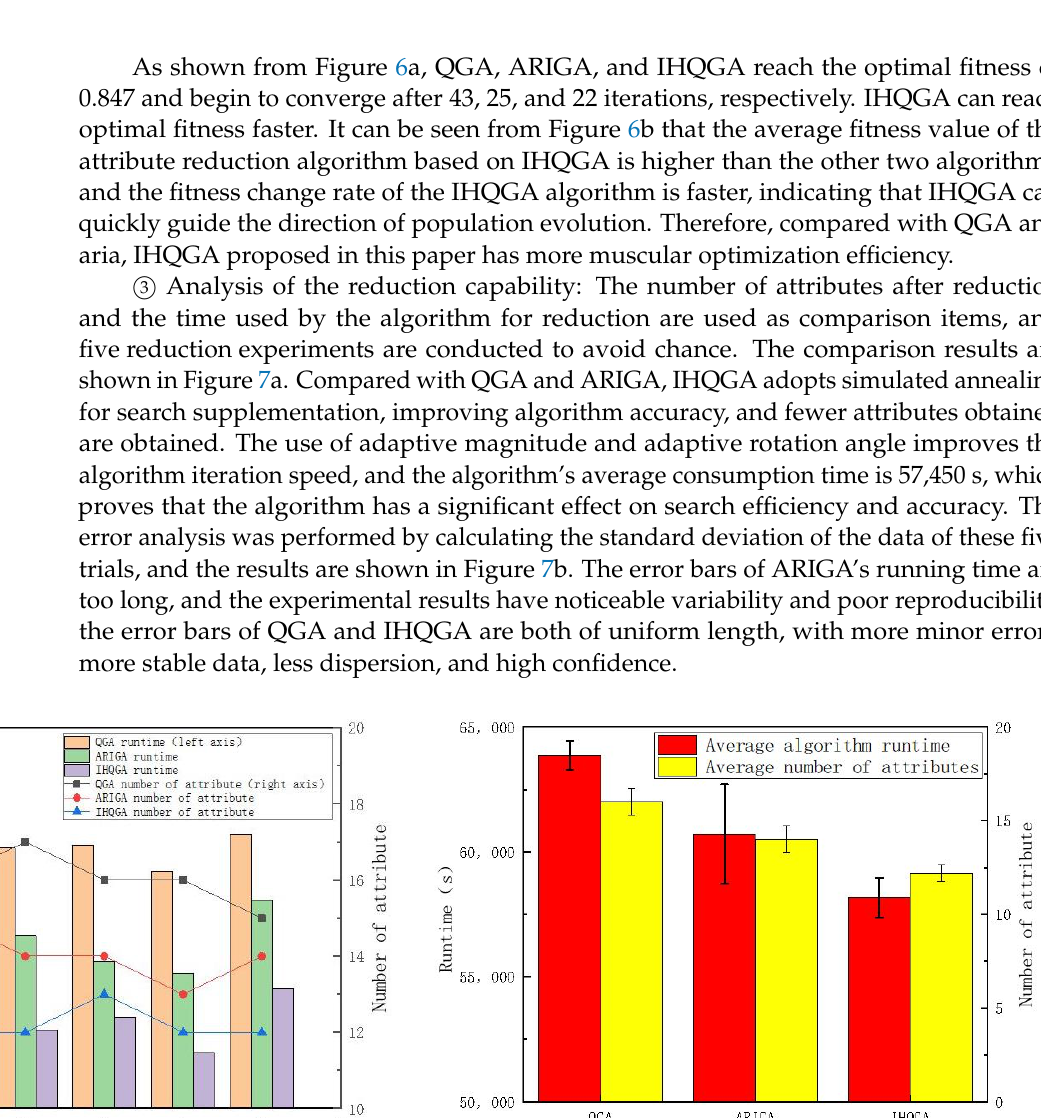
Table 8. Minimum decision table after reduction.